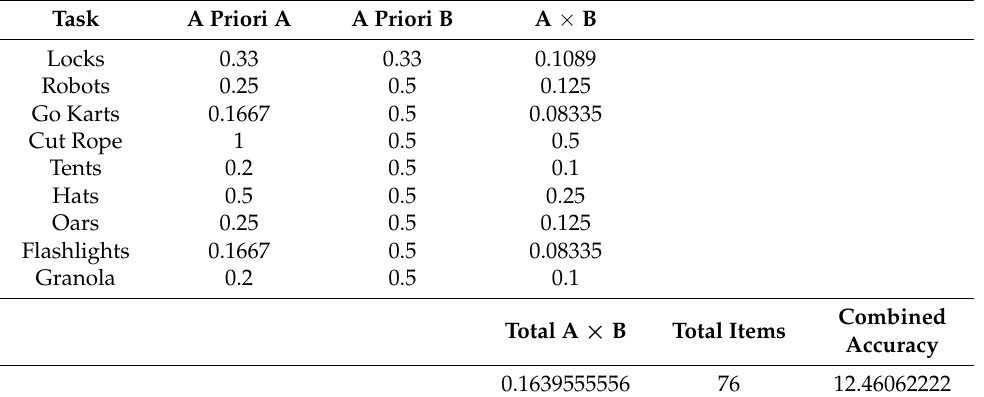
Table 2. Computing Baseline Probability.